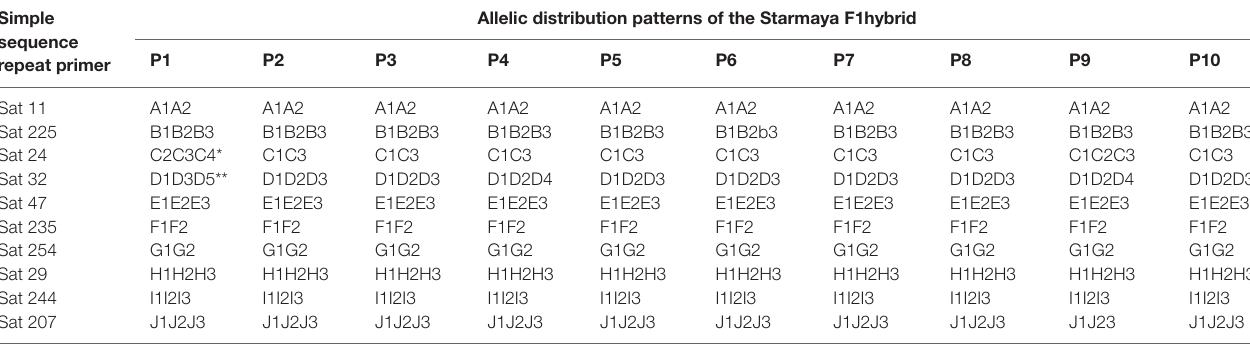
Allelic distribution patterns of the Starmaya